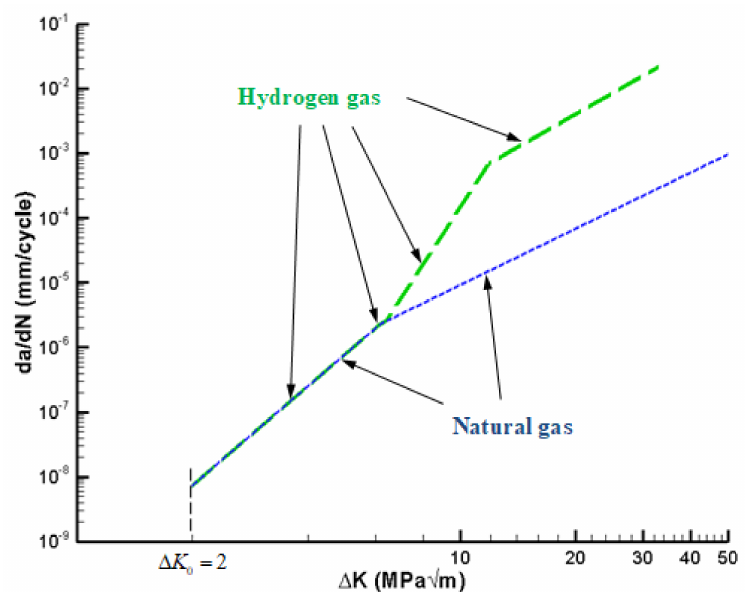
Figure 7. Diagram of the crack growth curve as a function of the stress intensity factor range ∆ K for natural gas (blue curve) and for hydrogen, (green